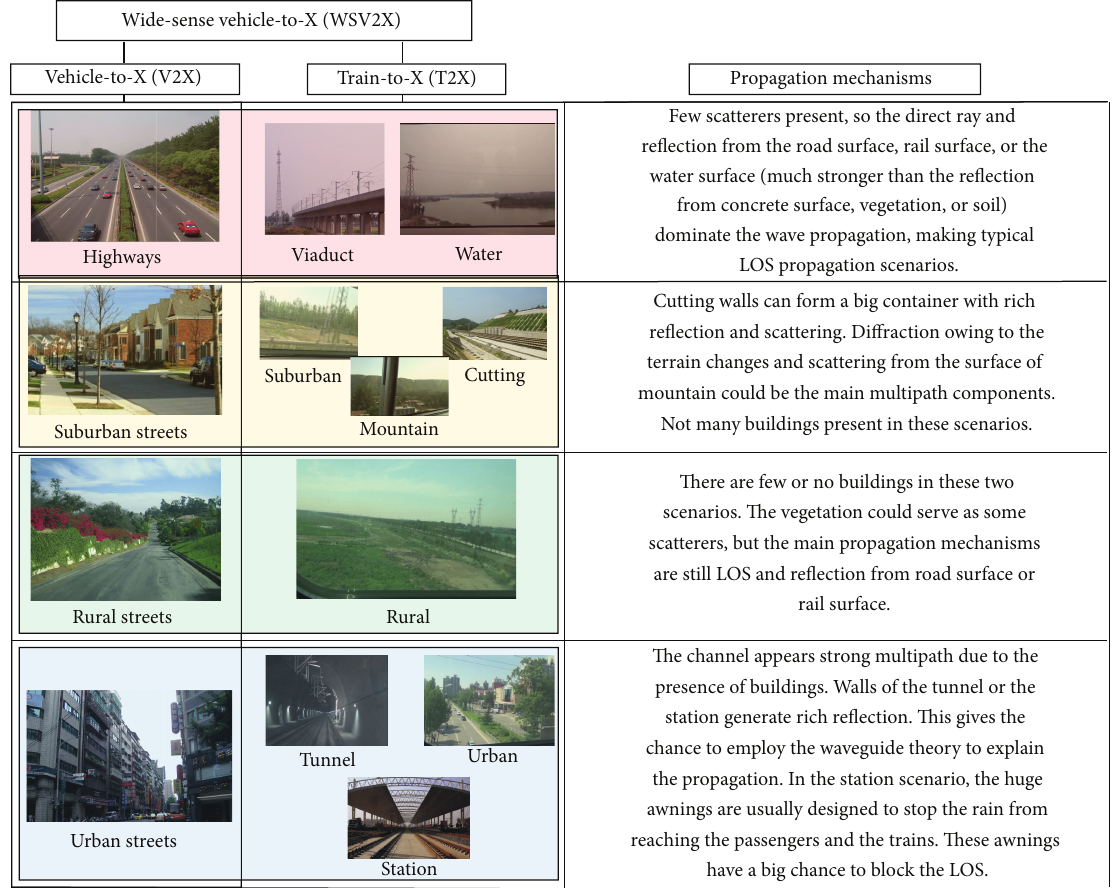
Figure 2: Typical scenarios of WSV2X channels. The scenarios in the same light colorful blocks are similar or